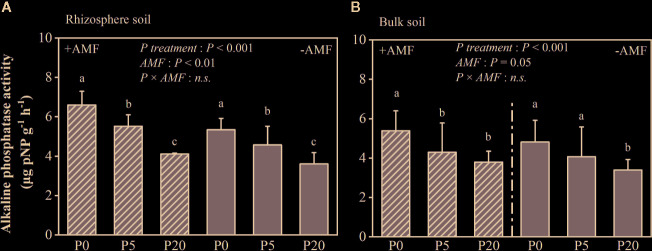
Alkaline phosphatase activity in the rhizosphere (A) and bulk soil (B). Data are presented as means ± S.E. (n = 4). Two-way ANOVA and Tukey’s test were performed for each AMF treatment (+AMF and −AMF) and P treatment (P0, P5, and P20). ANOVA P-values are indicated in the graphs. Significant differences (P < 0.05) between treatments are indicated with different letters above the bars.